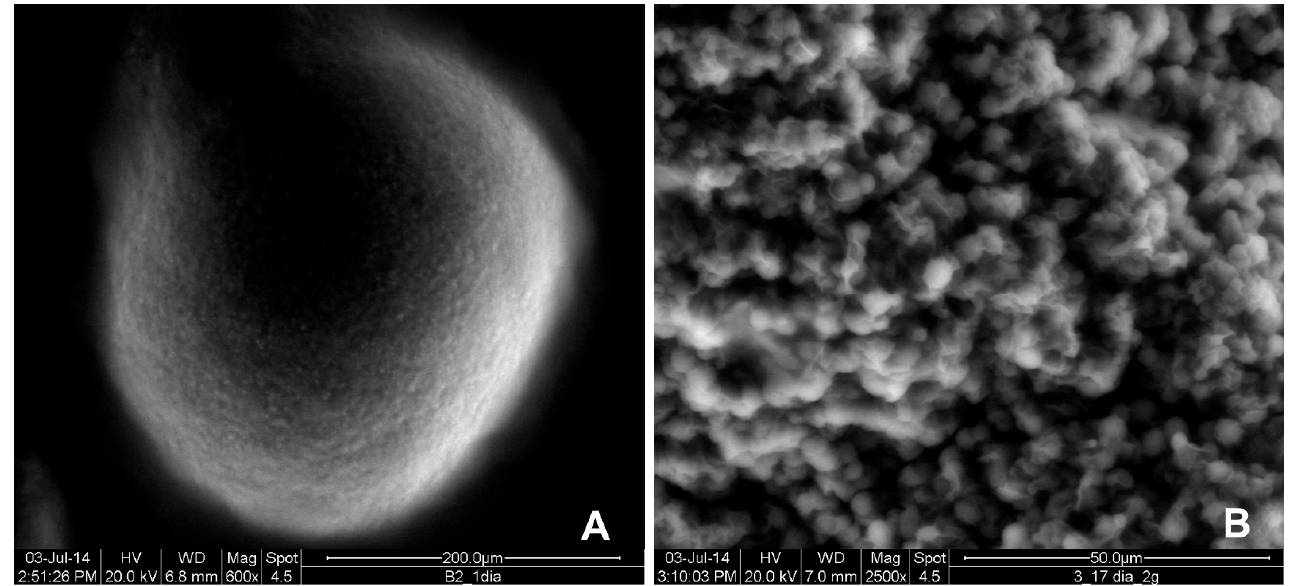
Figure 3. SEM image of S. cerevisiae cells, entrapped in double-layer alginate–chitosan beads: ( A ) double-layer bead with alginate 2% ( w / v ) and chitosan 1.0% ( w / v ) (×600); ( B ) external layer (chitosan 1.0% w / v ) of a bead after deacidification, pH 3.12 (×2500). For SEM analysis, double-layer alginate–chitosan beads, were dehydrated (5 min in 70 % v / v ethanol followed by 5 min in absolute ethanol) and dried using critical point dehydration. Beads were then mounted into aluminum stubs and coated with a small amount of gold/palladium in a Polaron Range SC7620 Sputter Coater (Quorum Technologies Ltd., Ashford, Kent, UK). SEM analysis was performed in a Philips-FEI/Quanta 400 scanning electron microscope (FEI, Hillsboro, OR, USA).